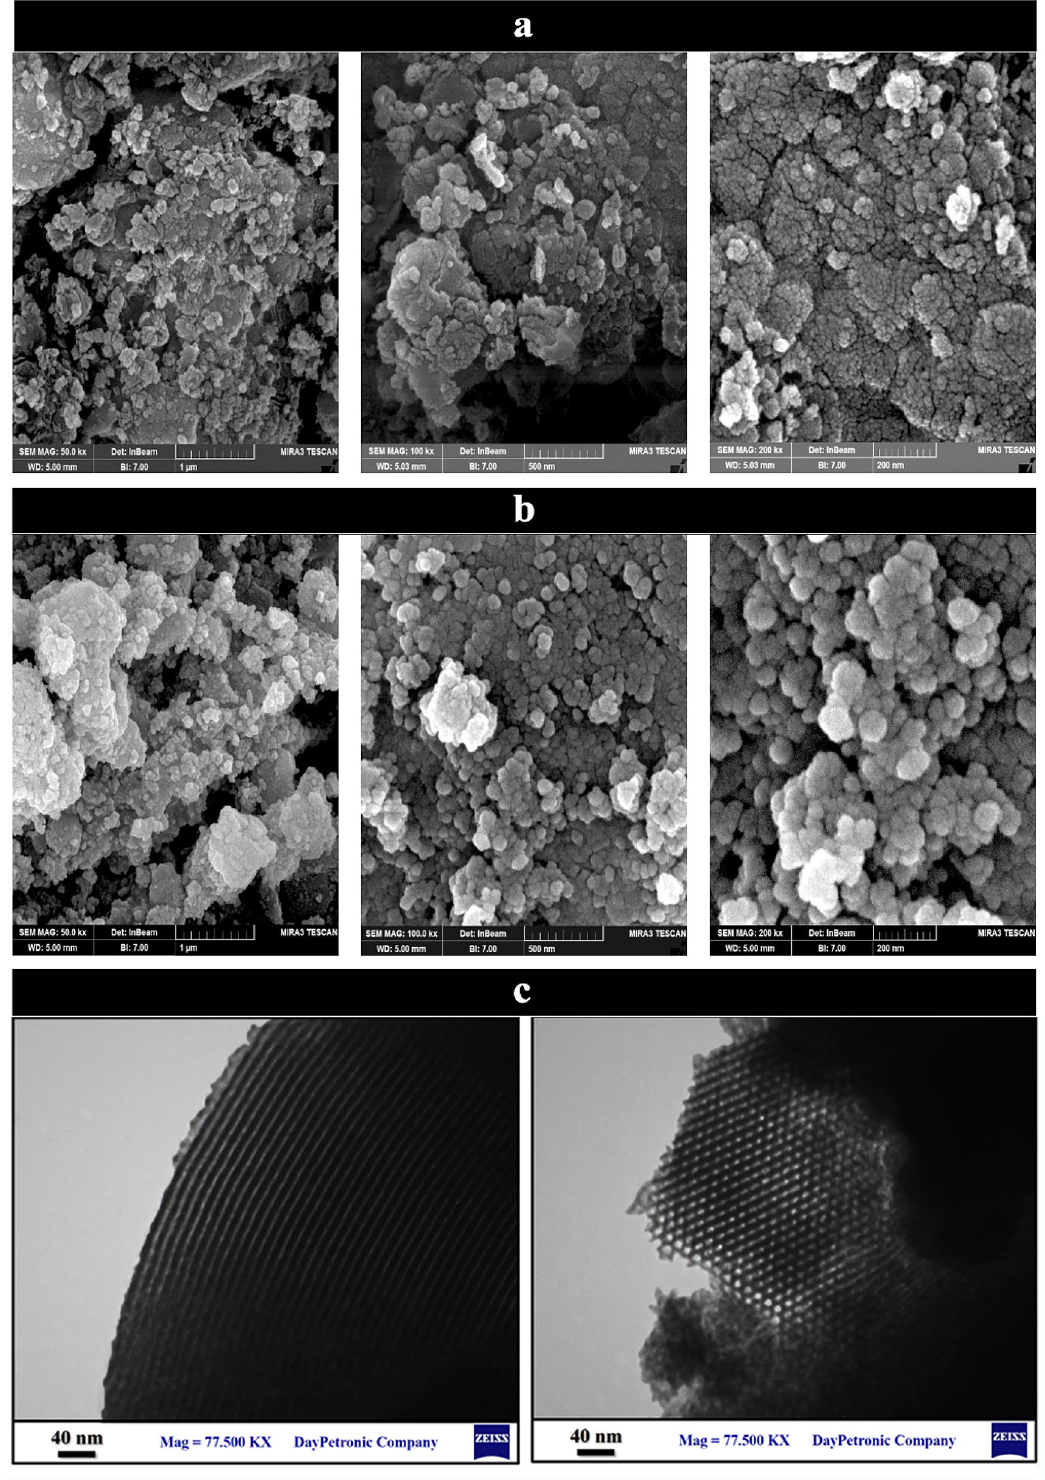
Figure 4. FESEM images of ( a ) SBA-15, ( b ) the guanidinylated SBA-15/Fe 3 O 4 , and ( c ) TEM image of the guanidinylated SBA-15/Fe 3 O 4